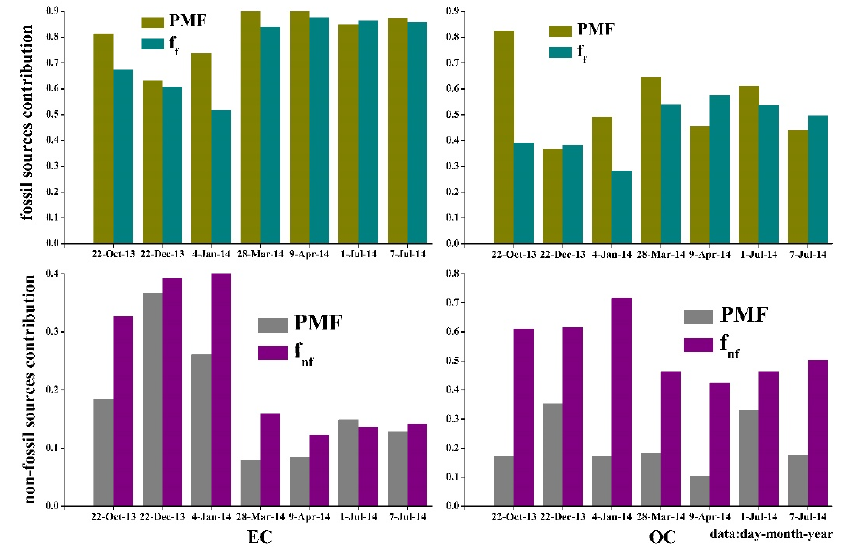
Figure 6. Comparison of the source contribution to EC and OC classified from the PMF results and the corresponding 14 C measurements (f f and f nf were fossil and non-fossil sources contribution to carbon species inferred from 14 C measurements, respectively).